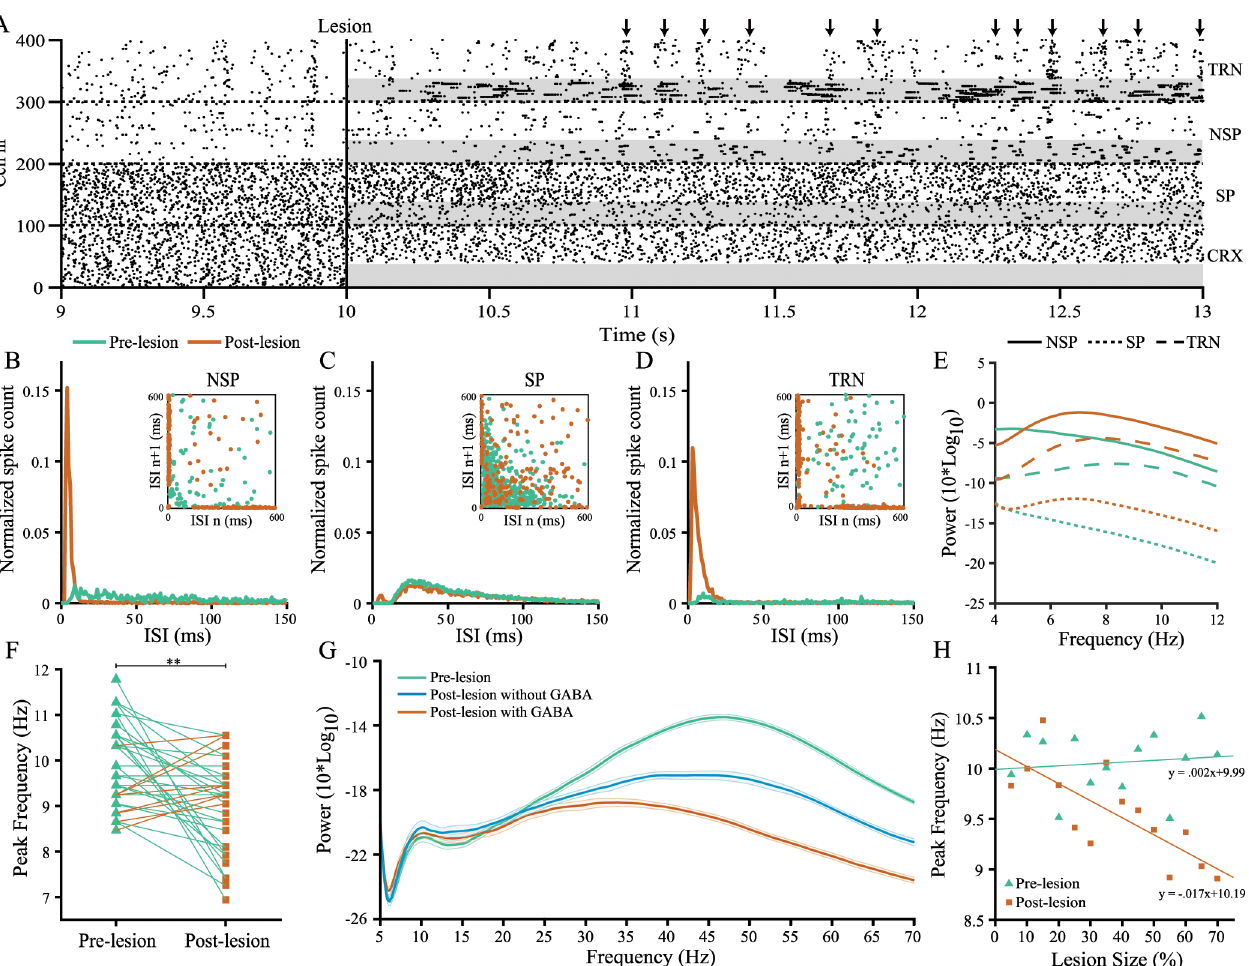
Fig 4. Model results. (A) Rasterplot of spikes for a single run of the model. From top to bottom: 100 neurons of the three thalamic nuclei TRN, NSP, SP plus the excitatory cortical population (CRX). A lesion was introduced after 10 seconds of real-time simulation time by deafferentating 30% of the cortical neurons, resulting in a loss of driving inputs for the thalamic neurons marked in grey. Arrows indicate entrained oscillations across the different nuclei. (B-D) Inter-spike intervals (ISI) for the NSP, SP and TRN, respectively. Most thalamic neurons pre-lesion are in a tonic- firing mode, with evenly distributed ISIs. After the lesion, the NSP and TRN switch to a bursting regime, with the majority of neurons having an ISI below 20 ms indicating intra-burst spikes, followed by longer inter-burst intervals. (E) Power spectra for the NSP (solid line), SP (dotted line) and TRN (dashed line) in the lower frequency range. All thalamic nuclei display a substantial increase of spectral power in the low-frequency range, peaking between 6 and 8 Hz, with the strongest oscillations present in the NSP and TRN. (F) Peak frequencies of the cortical power spectra in the range of 6 – 13 Hz, with an overall downward shift into a lower frequency post-lesion (9.2 ± 0.38 Hz) compared to pre-lesion (9.9 ± 0.44 Hz). Line colours indicate the highest corresponding frequency. (G) Average power spectra of the cortical component with and without the extrasynaptic increase of GABA post-lesion, with shaded areas representing the 95%-confidence intervals. The lesion affects γ -band power in both models post-lesion, but with an extrasynaptic increase of GABA, β -band power is further suppressed from 23 Hz onwards, comparable to the decrease for patients in their EEG. (H) Peak frequencies for different lesion sizes, averaged over 10 simulations per step. As the lesion size increases, the dominant α -peaks slow down towards a lower frequency post-lesion. Statistically significant differences marked as ** p < .01, Wilcoxon-rank sum